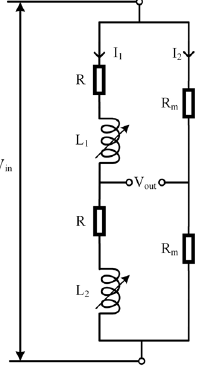
Figure 9. DCSFW excitation method.